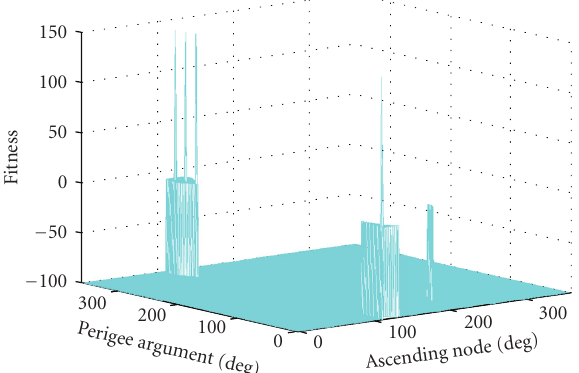
Figure 12: The fitness function variation versus the orbital